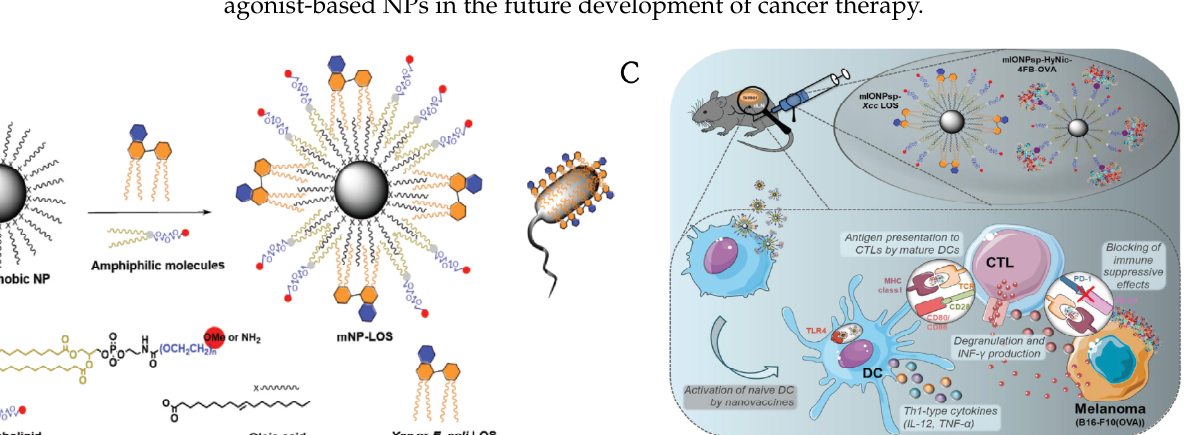
Figure 3. ( A ) General strategy for the conjugation of the antigen (OVA) to mIONPsp. ( B ) Schematic of the self-assembly process for the synthesis of the water-soluble and pathogen- mimicking nanoparticles (NP micelles (mNP) incorporating Xcc or E. coli LOS molecules). ( C ) The function of pathogen-mimicking magnetite nanoparticles via the TLR4 pathway.Reprinted with permission from Ref. [84] . Copyright 2018, copyright Wiley-VCH. ( D ) Schematic representation of the fabrication of IMDQnano. Reprinted with permission from Ref. [76] . Copyright 2018, copyright Wiley-VCH. 4.3. TLR7a Diversified TLR7 agonists nanostructures are conducted and comprehensively discussed below. TLR7, a member of the TLR family, is an intracellular receptor expressed on the endosomal membrane and can be triggered not only by ssRNA during viral infection but also by immune modifiers with a similar structure to nucleosides. The mechanism of TLR7 agonists is related to MyD88 dependent pathway and the Caspase- dependent mitochondrial pathway [103]. Different types of nanocarriers, such as polymer-